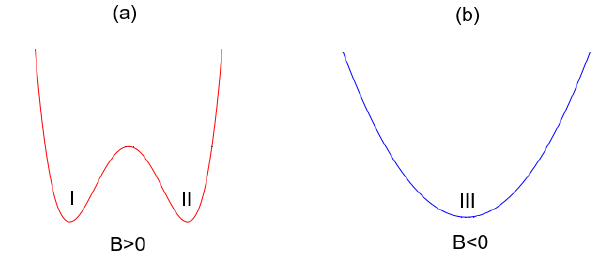
Figure 2. The potential U graph for oscillator (14) in case K ( 0 ) (cid:54) = 0. ( a ) B > 0. ( b ) B <